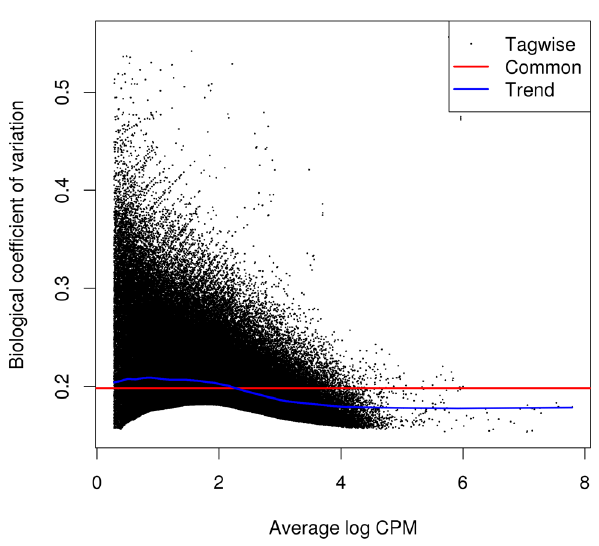
(red).Figure 5. Abundance-dependent trend in the BCV for each window, represented by the blue line. Common (red) and tagwise estimates (black) are also shown.